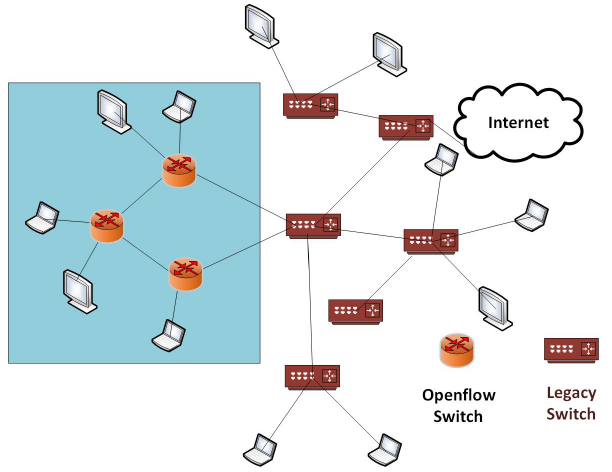
Figure 2. Example of hybrid SDN in an enterprise network: The network portion in the blue box needs fine-grained control and is upgraded to SDN, while the rest of the network continues to operate with legacy